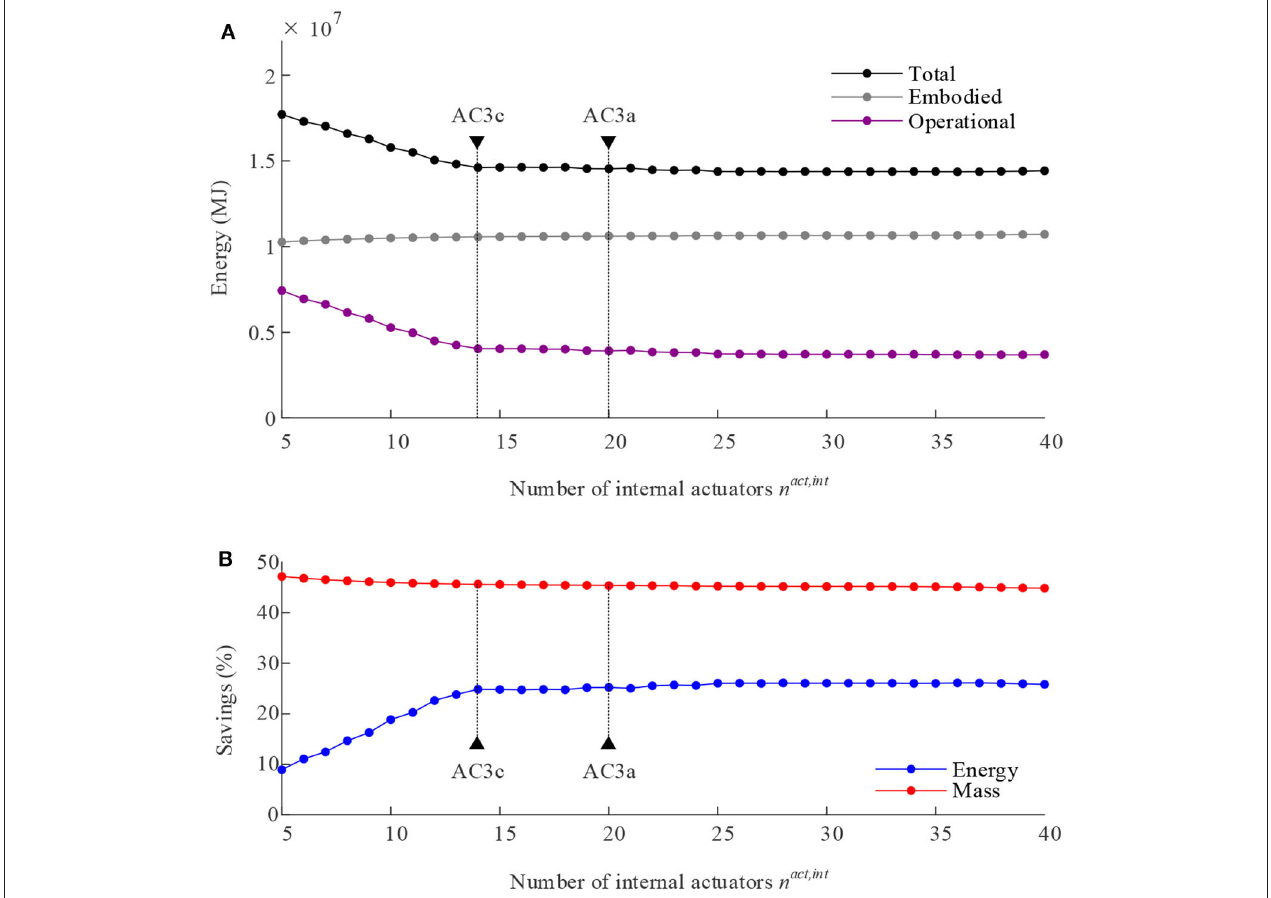
FIGURE 3 | Multi-story structure: (A) total, embodied, and operational energy; (B) energy and mass savings vs. the number of internal actuators.